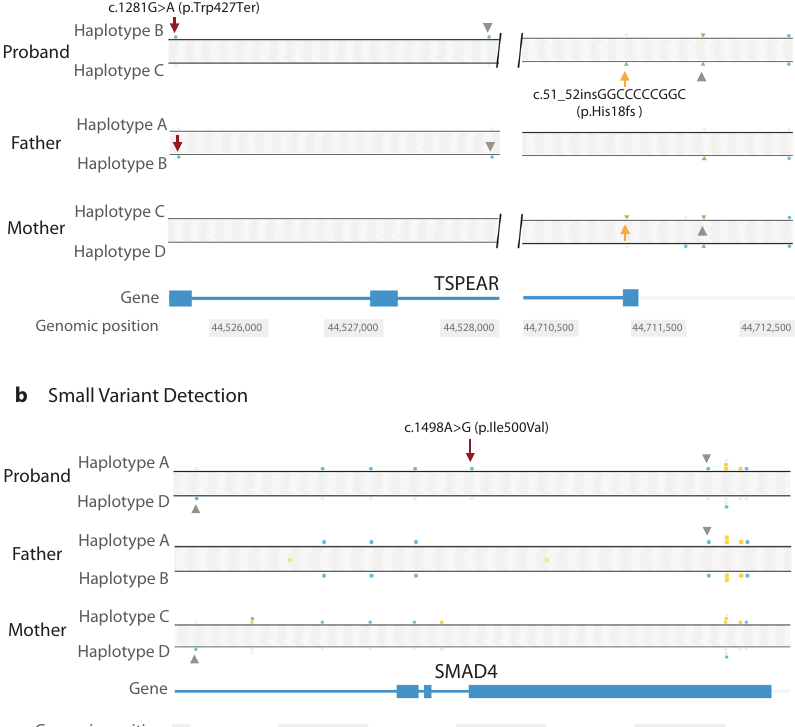
Fig. 4 Variant haplotype distinction. a Shows compound heterozygous TSPEAR variants (NM_144991). Phasing was successful for etiologic variants 184,756 bp apart given a phasing block of 15.1 Mb, which is not possible with short-read sequencing. Maroon and yellow arrows point to each variant. Gray arrowheads point to single-nucleotide polymorphisms that con fi rm trans orientation in relation to parental haplotypes. b Shows a de novo SMAD4 pathogenic variant (NM_005359) identi fi ed by linked-read sequencing, also detectable by short-read sequencing. Haplotype analysis showed the variant occurred on the paternally inherited allele, Haplotype A. Variant position is indicated with a maroon arrow. Gray arrowheads point